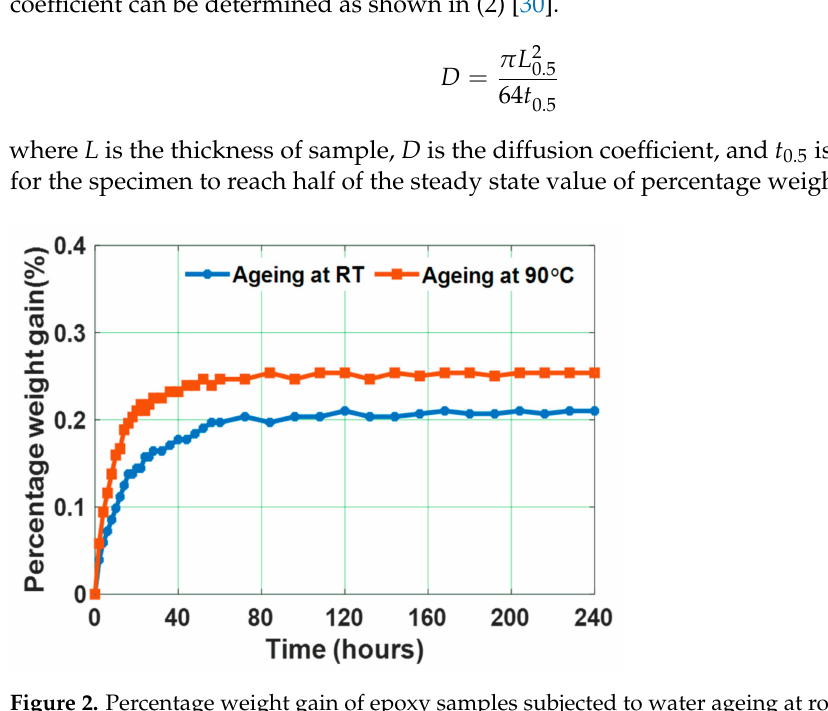
Figure 2. Percentage weight gain of epoxy samples subjected to water ageing at room temperature (RT) and 90 ◦ C